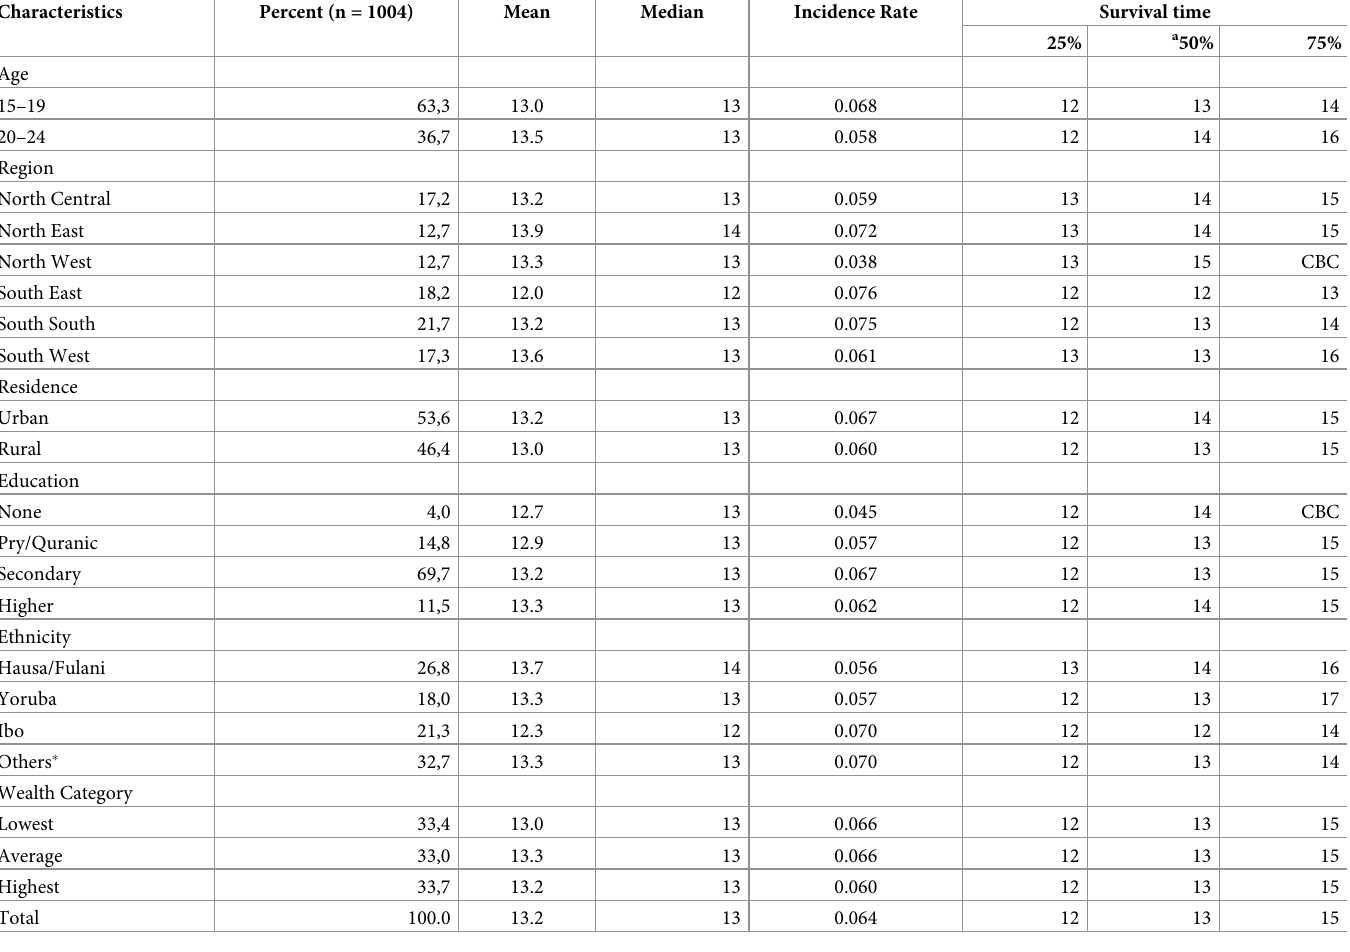
Table 2. Distribution of time to pubarche and incidence rate among females by selected characteristics.